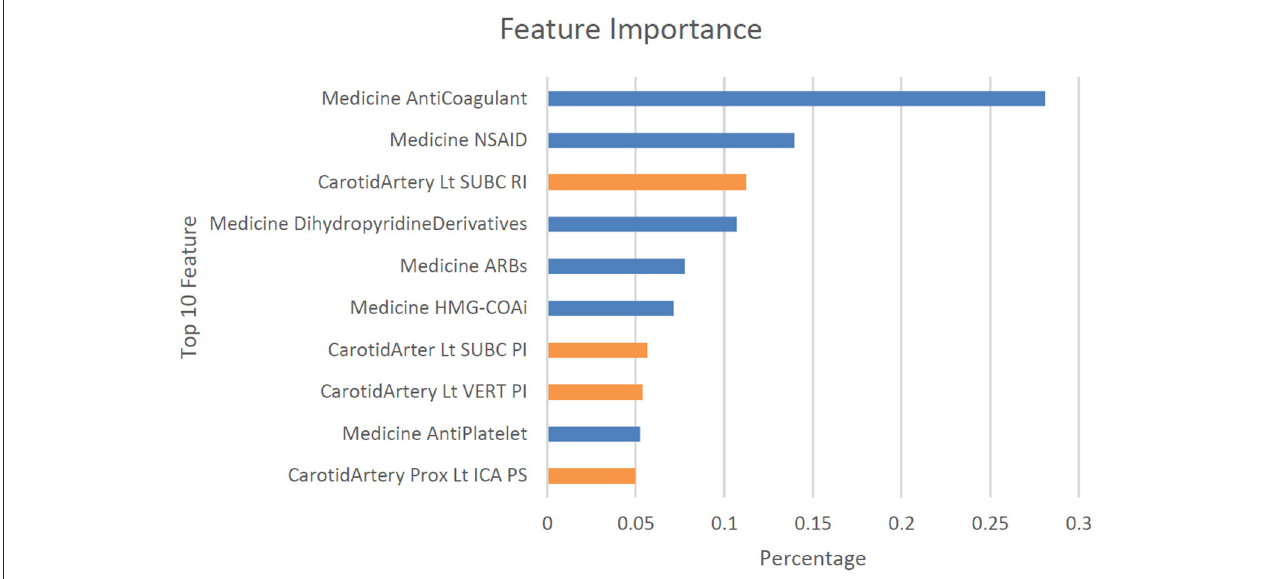
FIGURE 4 | Top 10 features observed in the CatBoost model without balancing method for classifying stroke once and recurrent stroke. Dist, distal; Lt, left, Rt, right; CCA, common carotid artery; ICA, internal carotid artery; ECA, external carotid artery; SUBC, subclavian artery; VERT, vertebral artery; BA, basilar artery; Prox, proximal; TCD, transcranial Doppler; PI, pulse index; RI, resistive index; TAMEAN, intensity-weighted mean frequency; EDV, end-diastolic velocity; PSV, peak systolic